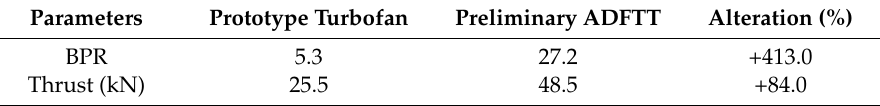
Table 3. Comparison between the Prototype Turbofan and the Preliminary ADFTT.